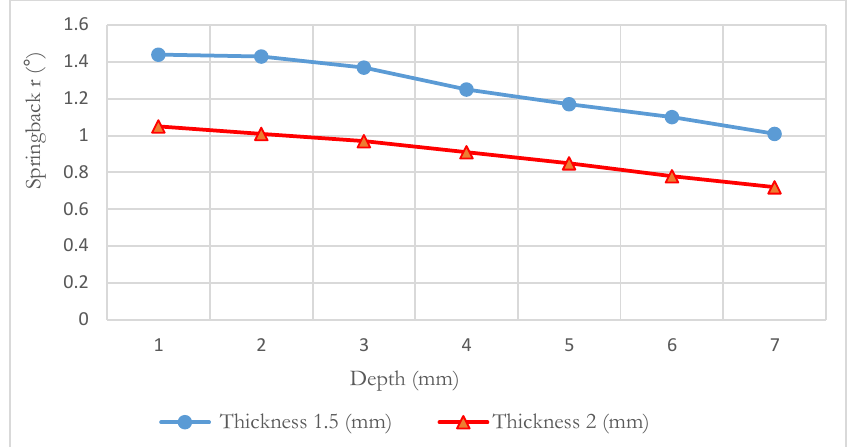
Fig. 10. The evolution of the experimental springback as a function of the depth